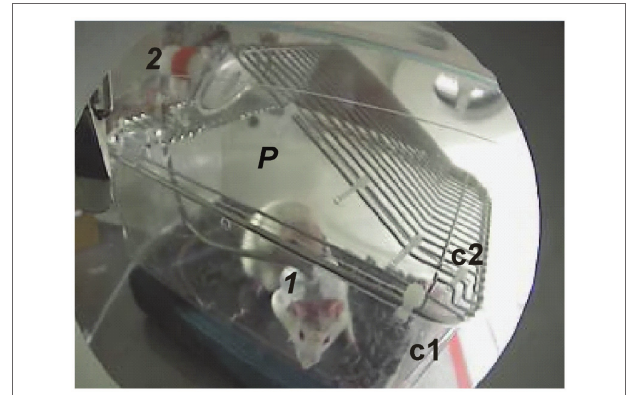
FIGURE 3 | A video image captured at the beginning of an experiment showing the rat’s jacket and tether (1) and the tether assembly (2) mounted on the inverted wire cage lid (c2). The metal triangular-shaped side panel was removed, which normally reinforces the depression that supports an animal’s water bottle and replaced with a plexiglass panel (P) so the animal inside the cage (c1) could be viewed using the video camera.